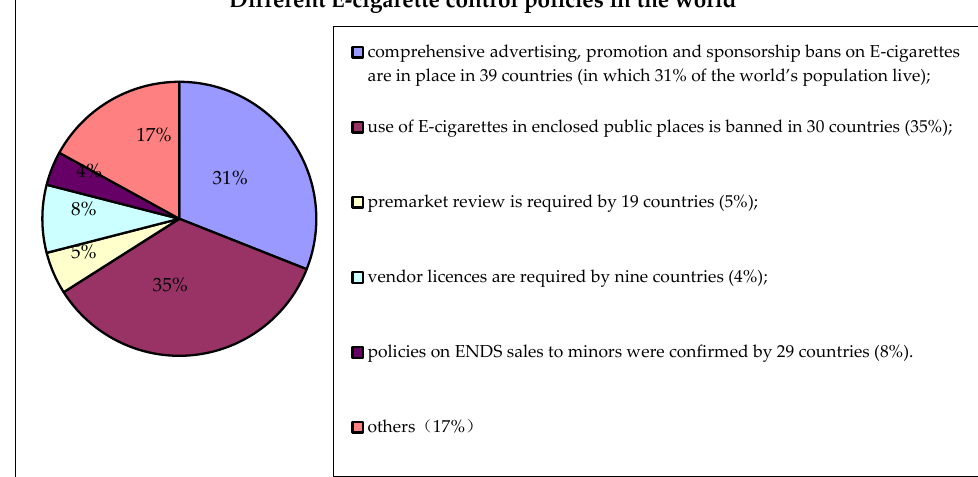
Figure 2. Different E-cigarette control policies in the world [2].